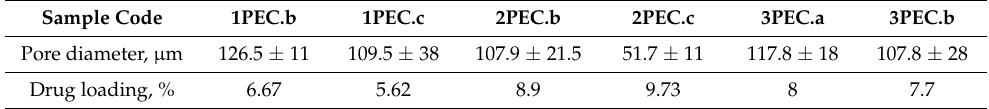
Table 2. Pore diameter and drug loading of PEC cryogels selected for the investigation of CCM